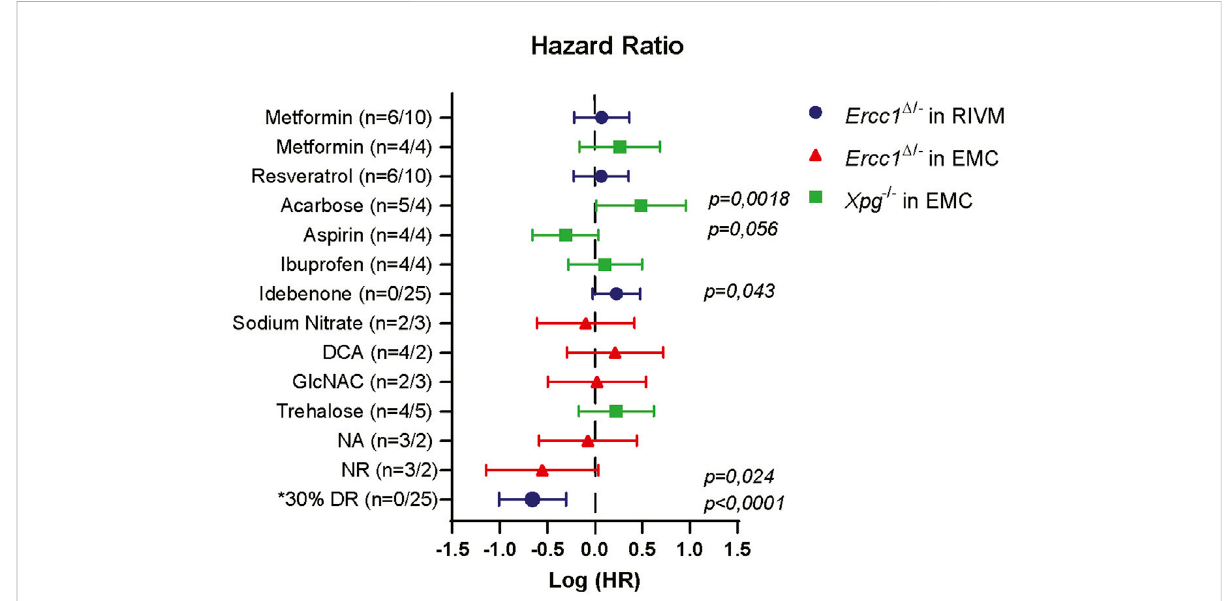
FIGURE 4 Comparison of lifespan changes induced in NER de fi cient mice. Forest plot showing the effectiveness of different intervention on extending lifespan in Ercc1 Δ / − and Xpg − / − mice across two testing location. Plotted is the logarithm of hazard ratio (HR) with 95% logarithm con fi dence intervals as error bars when each treatment group is compared to its relevant control group. Lifespan extension was noted upon supplementation with NR. Signi fi cant (and close to) logrank (Mantel-Cox) p values are shown. Log(HR) below 0 indicate extension in lifespan and above 0 decline in lifespan. Number in brackets indicate number of animals (male/female). *Hazard ratio of DR group is calculated from Birkisdóttir et al.